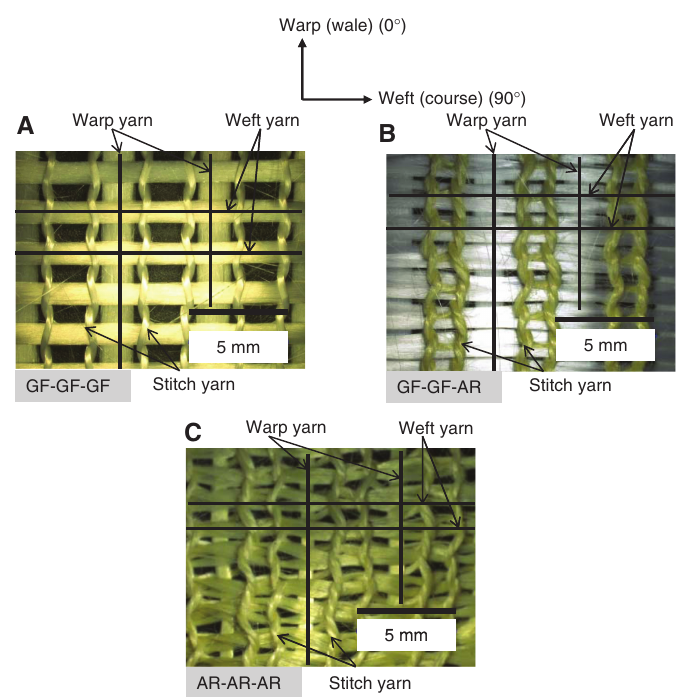
Figure 1 Photographs of BWK reinforcement fabrics.